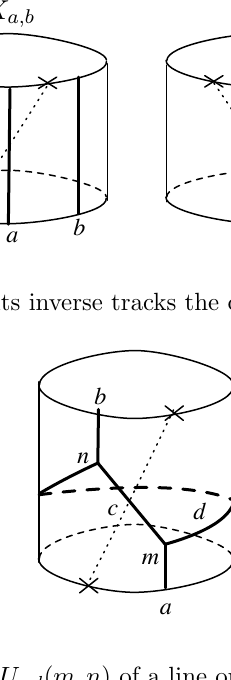
Figure 23 . The action U c;d ( m; n ) of a line operator wrapped around S 1